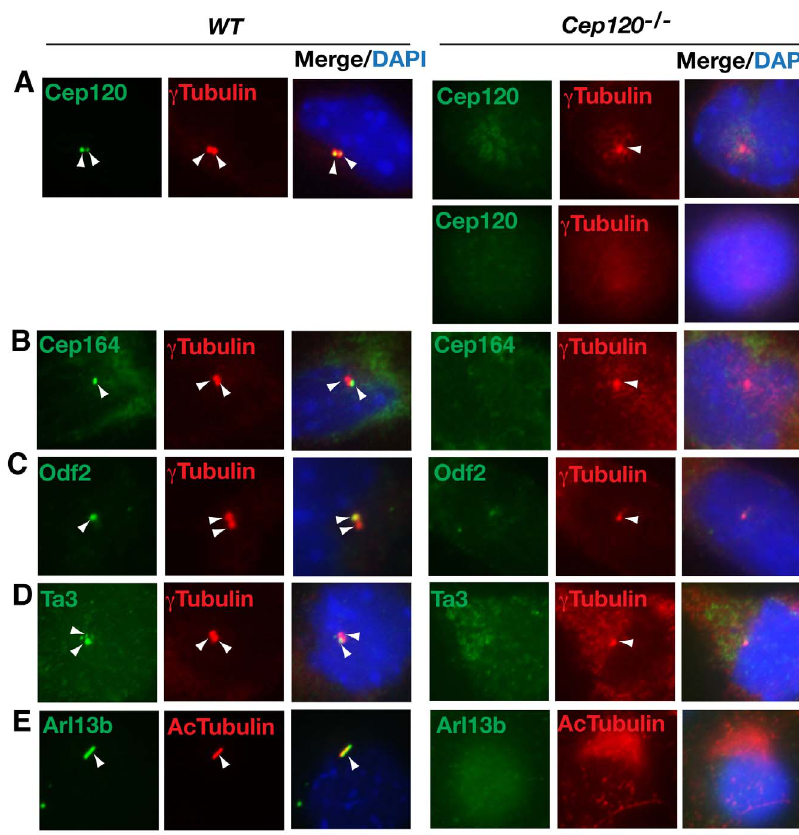
Figure 7. Cep120 is required for centriole duplication and ciliogenesis. Wild type and Cep120 -/- pMEFs were coimmunostained for the indicated proteins. Most Cep120 mutant cells lacked either one or both centrioles, as indicated by c ˜ tubulin staining. Staining for Cep164, Ta3, and Odf2 showed that the missing centriole was the mother centriole. Staining for Arl13b and acetylated a˜ tubulin indicated no cilia being formed in Cep120 mutant cells. Arrowheads point to the staining of c˜ tubulin (a centriole marker), the indicated proteins, or cilia.